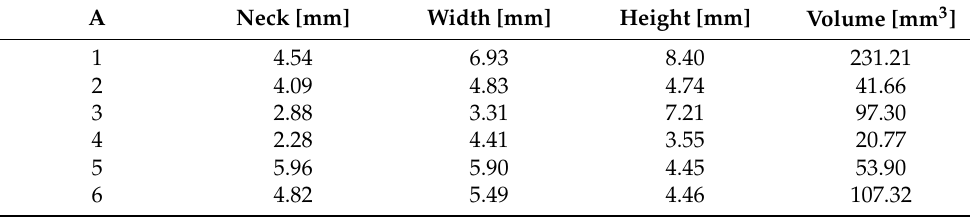
Table 2. Geometric dimensions values of each aneurysm